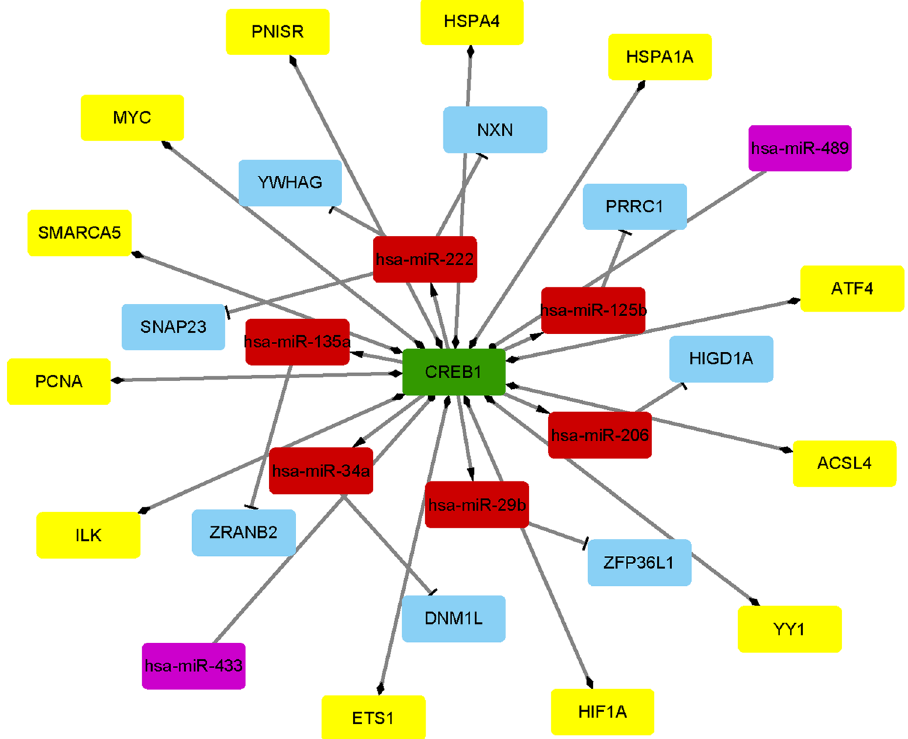
Figure 8. CREB1 regulatory network. Green node indicates CREB1. Red nodes indicate predicted target miRNAs of CREB1. Blue nodes represent target DEGs of miRNAs. Purple nodes represent predicted miRNAs regulating CREB1. Yellow nodes represent DEGs interacting with CREB1 in the PPI network. The arrow indicates the CREB1-miRNA target relationship and the T shape represents the miRNA-target relationship. The circle represents the miRNA-CREB1 target relationship and the diamond represents CREB1-DEGs relationship. Differentially expressed genes, DEGs, Protein–protein interaction, PPI. Created with cytoscape software 3.6.1 (www. cytos cape.